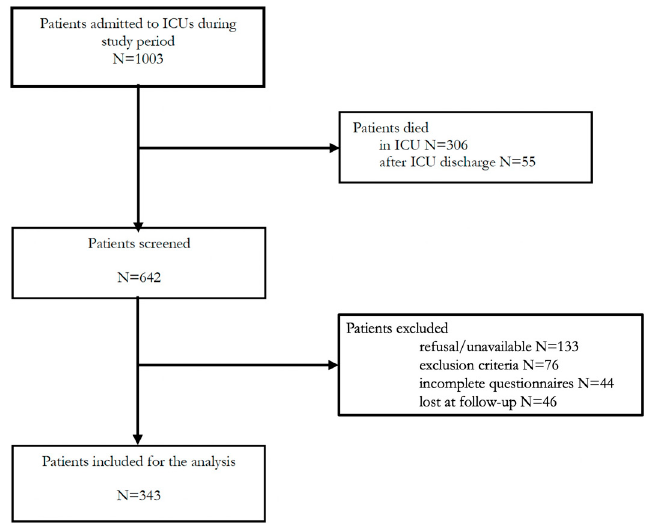
Figure 1. Study flow chart.